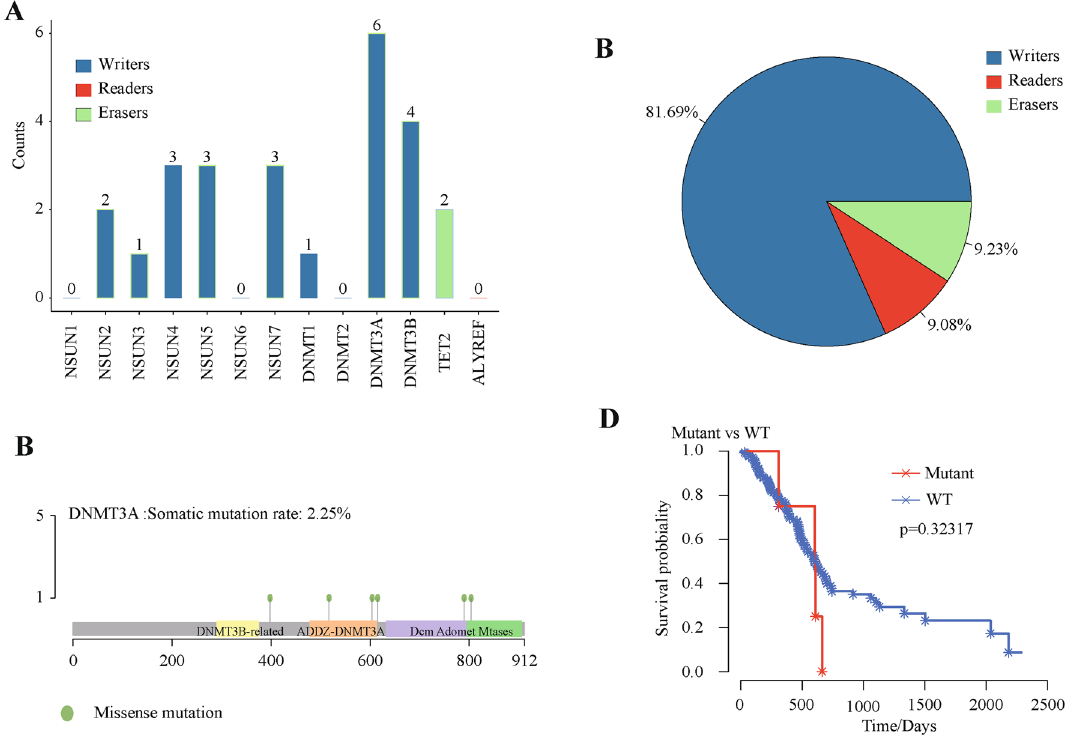
Figure 1. CNVs, mutations, and SNVs of m5C regulatory genes in PAAD. A total of 363 PAAD patients from TCGA were analyzed. ( A ) Mutation frequencies in m5C regulatory genes with indicated functions. ( B ) Mutation sites in DNMT3A . ( C ) Seven functionally altered genes and patient survival. P value did not reach significance due to the small number of mutations. ( D ) CNV statistics of m5C regulatory genes in PAAD samples. Writers accounted for 81.69%, which was highest. Readers and erasers made up almost the same proportion at approximately